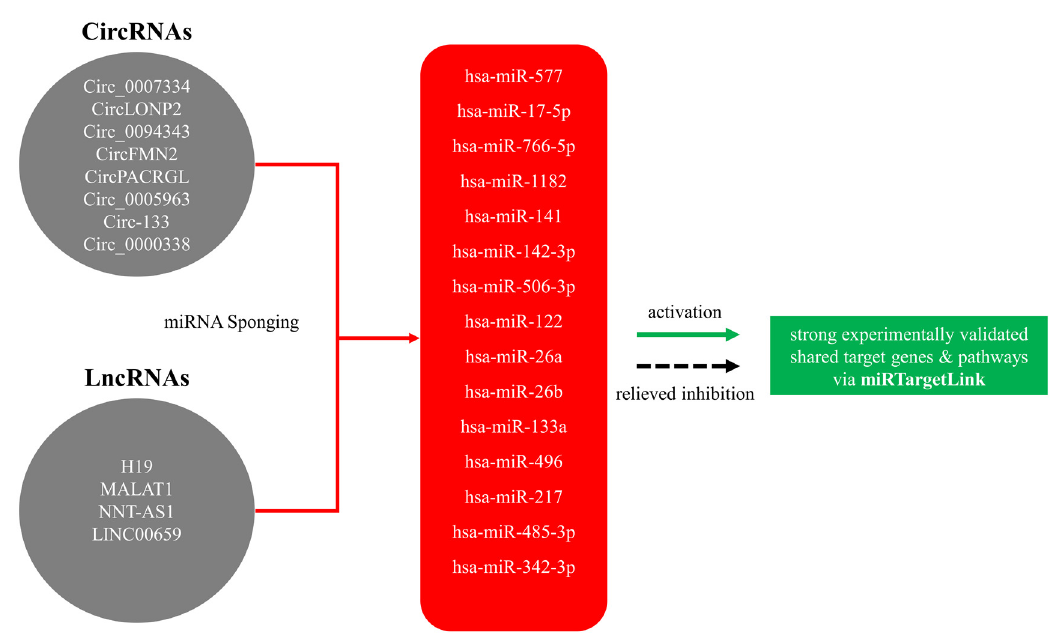
Figure 2. The colorectal cancer exosomal lncRNA/circRNA–miRNA–target axis.